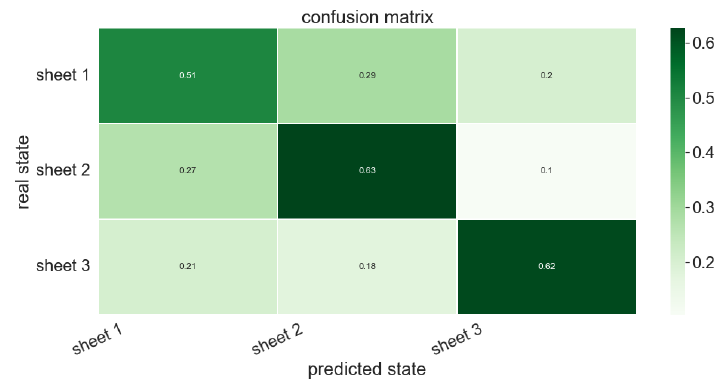
Figure 7. Confusion matrix related to the profiles of the three composite sheets.